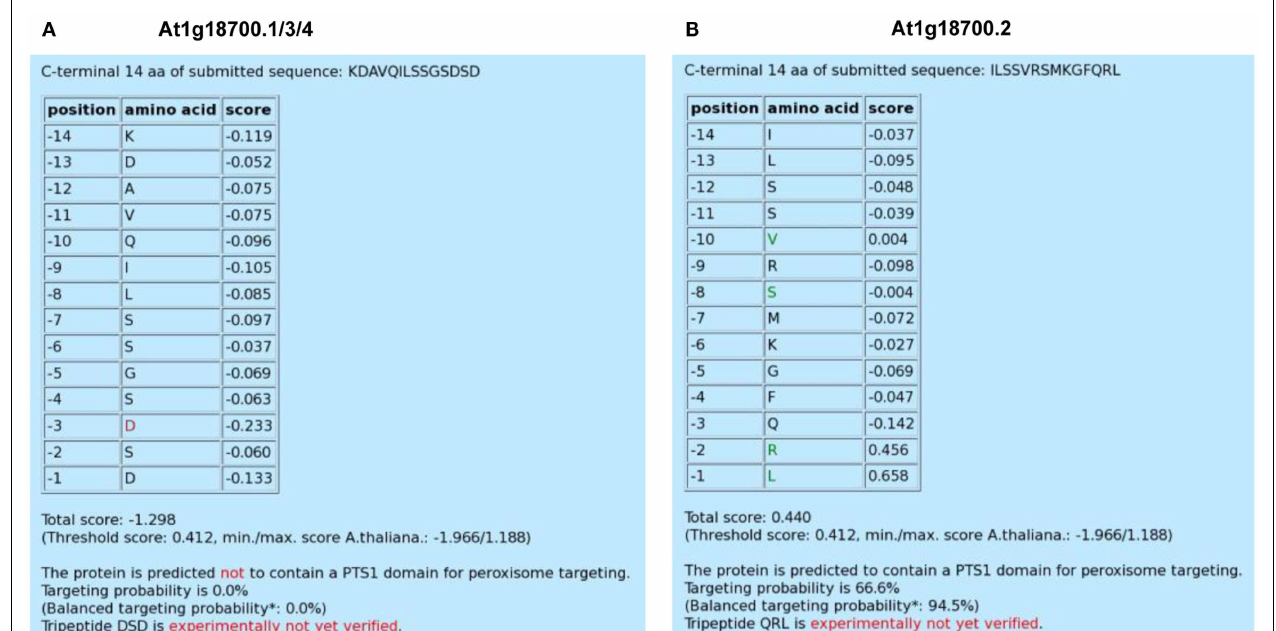
FIGURE 1 | Screenshot of the PredPlantPTS1 result page for three alternative splice variants (At1g18700.1/3/4) of an unknown DNAJ heat shock N-terminal domain-containing protein carrying the same C-terminal domain (A) and the specific variant,At1g18700.2, which terminates with the putatively novel PTS1 tripeptide, QRL > . (B) All four